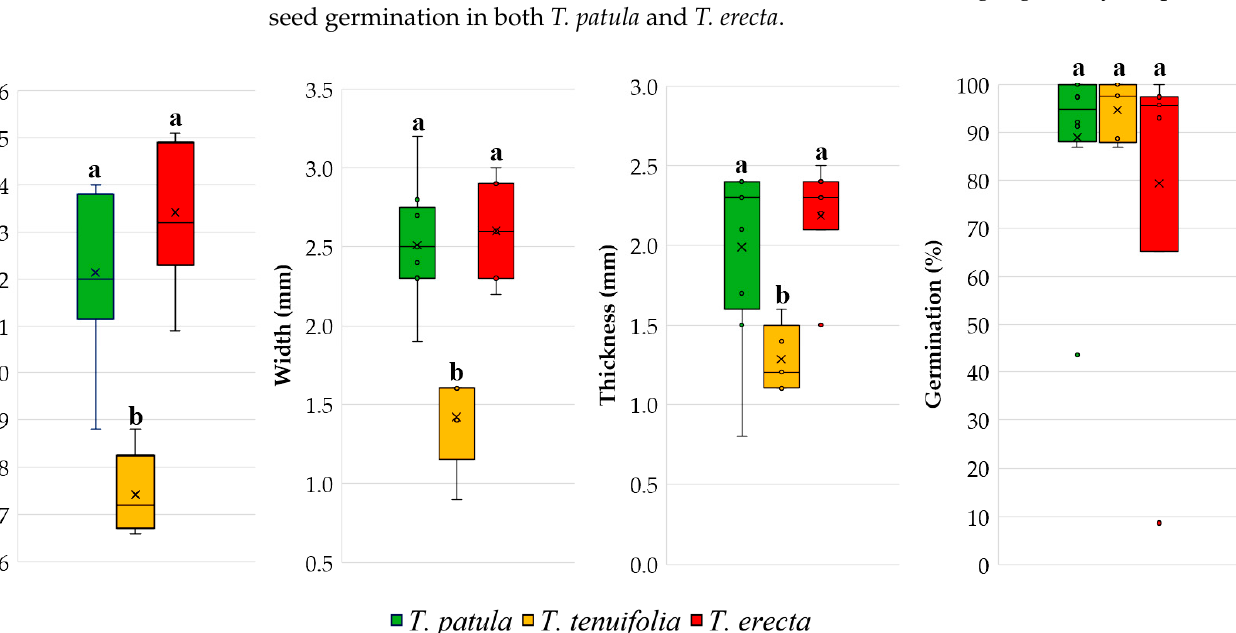
for seed length (CV% = 22.3) and Orange Flame, with CV% just over 20%, for seed width and thickness. Boxplots and Duncan multiple range tests (Figure 1) highlight the differences between the three species of Tagetes for the three main traits of the seeds. Between T. patula and T. erecta , there were no significant differences between the means of seed length, width and thickness. In contrast, the mean values of these traits in T. tenuifolia were significantly lower than those of the first two species mentioned. Only for seed germination, T. tenuifolia does not differ significantly from the other two species, T. patula and T. erecta . The graphs also suggestively indicate the dispersion of data within and between species. For the characteristics of the seeds, the whiskers of the boxplots suggest a large dispersion of the cultivar values in T. patula . Outliers or abnormal values, marked by small dots, appear only in T. erecta for seed thickness. Instead, such aberrant values are highlighted by boxplots for seed germination in both T. patula and T. erecta .